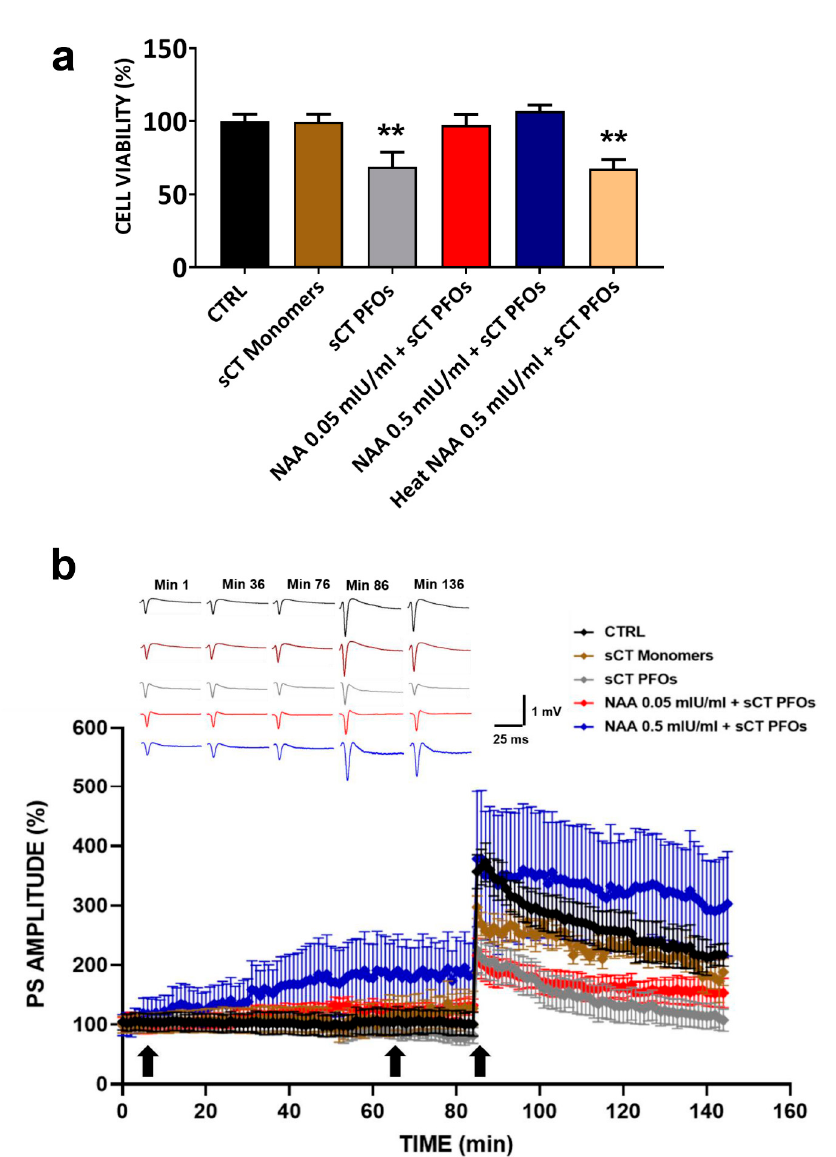
Figure 2. ( a ) Cell viability assessment in HT22 cells treated with Neuraminidase (NAA) and salmon Calcitonin (sCT): HT22 cells pre-treated with NAA at concentrations of 0.05 mIU/mL (red bar, n = 21 from N = 5 experiments) and 0.5 mIU/mL (blue bar, n = 16 from N = 4 experiments) for 1 h and then incubated with Prefibrillar Oligomers of salmon Calcitonin (sCT PFOs) for 24 h showed cell viability comparable to that of the CTRL group (black bar, n = 34 from N = 5 experiments). Treatment with sCT PFOs (grey bar, n = 20 from N = 5 experiments) significantly reduced cell survival by approximately 30% (** p < 0.01), whereas treatment with sCT monomers (brown bar, n = 17 from N = 4 experiments) did not affect cell viability. Finally, pre-treatment with heat NAA 0.5 mIU/mL + sCT PFOs (pink bar, n = 14 from N = 3 experiments) induced a reduction in cell viability of approximately 30%, like that obtained when HT22 cells were treated with sCT PFOs (** p < 0.01). ( b ) Synaptic plasticity in CA1 subfield of mouse hippocampal slices following NAA and sCT administration: % Population Spike (PS) amplitude as a function of time after tetanic stimulation (HFS), applied at time t = 86 min (arrow), following NAA ( t = 5 min, arrow) and sCT ( t = 65 min, arrow) administration, is shown in CTRL (black bar, n = 6), in sCT monomers (brown bar, n = 4), in sCT PFOs (grey bar, n = 4), in NAA 0.05 mIU/mL + sCT PFOs (red bar, n = 7), and in NAA 0.5 mIU/mL + sCT PFOs (blue bar, n = 5) mice slices at minutes 1, 36, 76, 86 and 136. The insert shows representative recordings obtained from slices of each experimental group; curves of each group refer to PS at times 1, 36, 76, 86 and 136